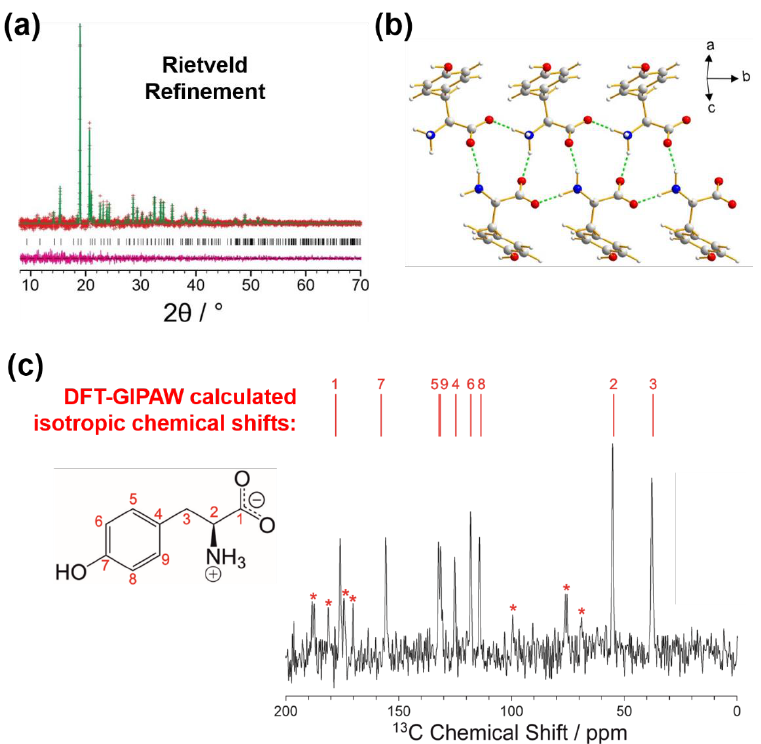
Figure 10. ( a ) Final Rietveld refinement of the powder XRD data for the β polymorph of L -tyrosine, showing a very good quality of fit, and ( b ) the hydrogen-bonding arrangement in the final refined crystal structure. ( c ) Experimental high-resolution solid-state 13 C NMR spectrum for the β polymorph of L -tyrosine together with the values of isotropic 13 C NMR chemical shifts calculated by DFT-GIPAW methodology for the crystal structure (indicated by the red lines above the spectrum). Spinning sidebands in the experimental spectrum are marked by asterisks.